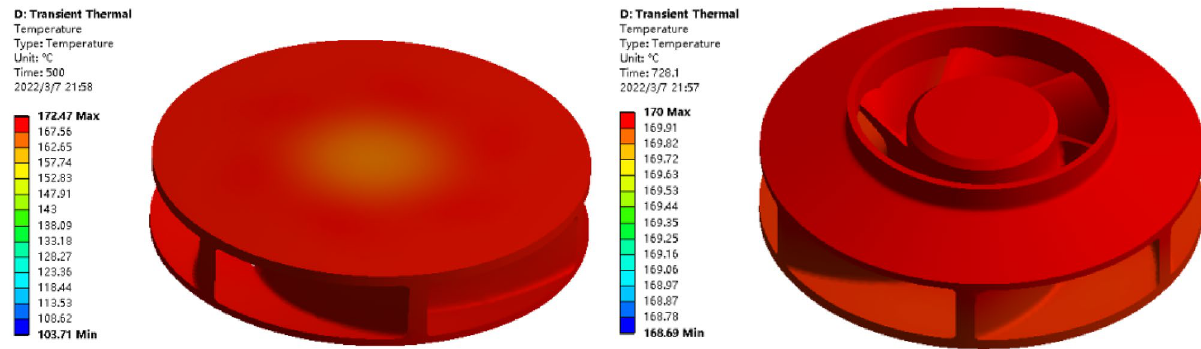
Figure 9. Simulation calculation results.